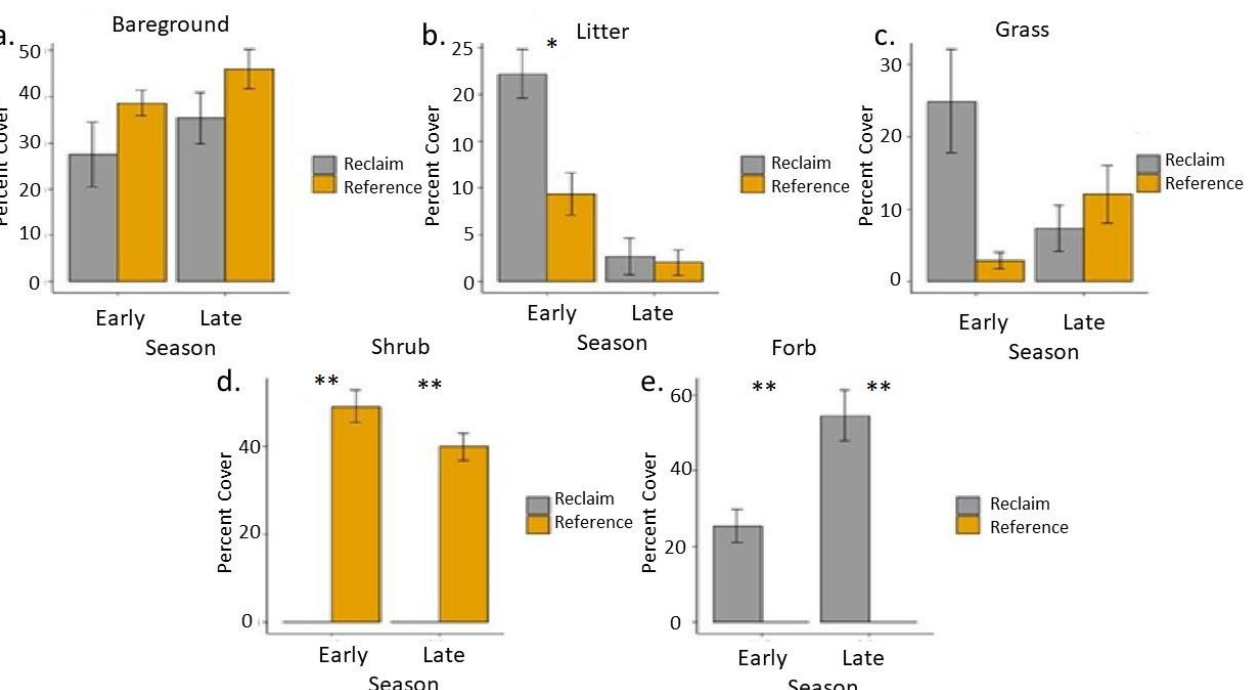
Figure 1. Bar graphs showing percent cover of ( a ) bare ground, ( b ) litter, ( c ) grass, ( d ) shrubs, and ( e ) forbs on reclaimed and reference sites which were monitored in early season and late season. * p -value < 0.05, ** p -value < 0.001.